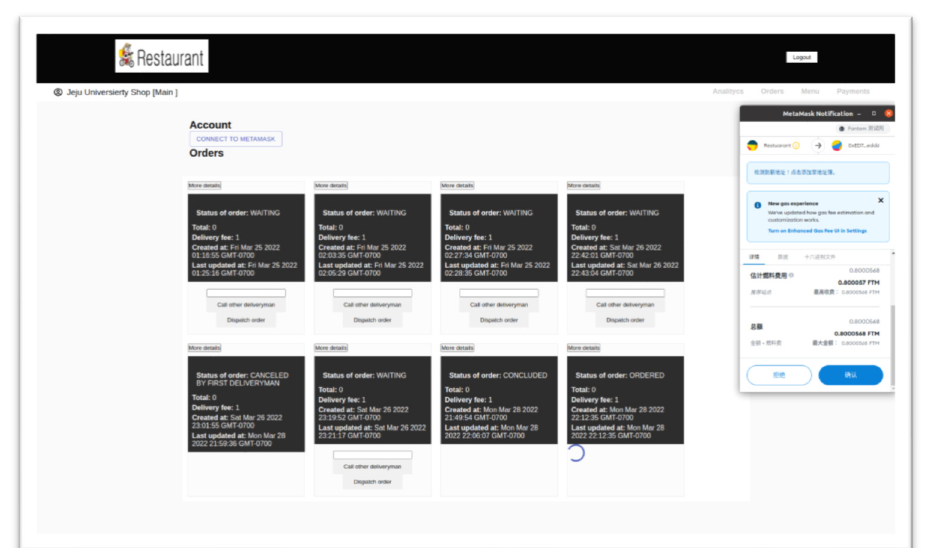
Figure 42. Restaurant client demo part in DAPP (Accept order).